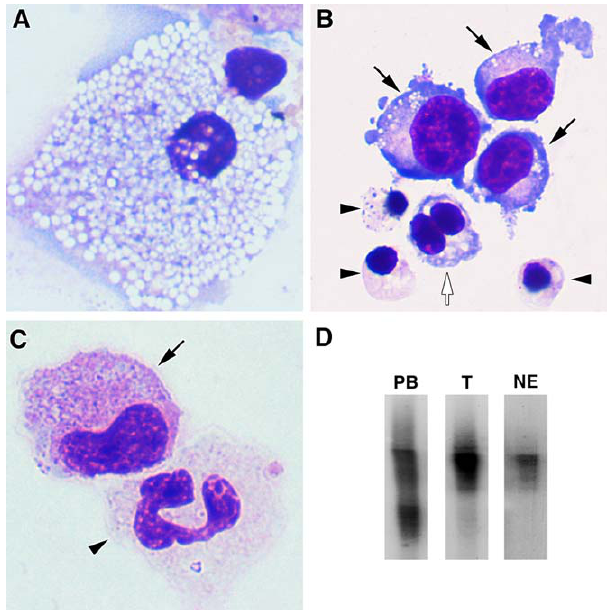
Figure 4. Hematopoietic Progenies Are Derived from Hemangioblasto- ma Tumor Cells (A) Giemsa staining of the vacuolated neoplastic stromal cell of the hemangioblastoma. (B) Giemsa staining of early (arrows), late (arrowheads), and dividing (open arrow) nucleated erythrocytes expanding in an erythropoietin- enriched medium. (C) Giemsa staining of immature (arrow) and mature (arrowhead) polynuclear granulocytes expanding in an erythropoietin-enriched medium. (D) While loss of heterozygosity was not detected in peripheral blood mononuclear cells (PB), deletion of the wild-type VHL allele occurred in cultured hemangioblastoma (T) and cultured nucleated erythrocytes (NE), confirming the hemangioblastic origin of the nucleated erythroid cells.